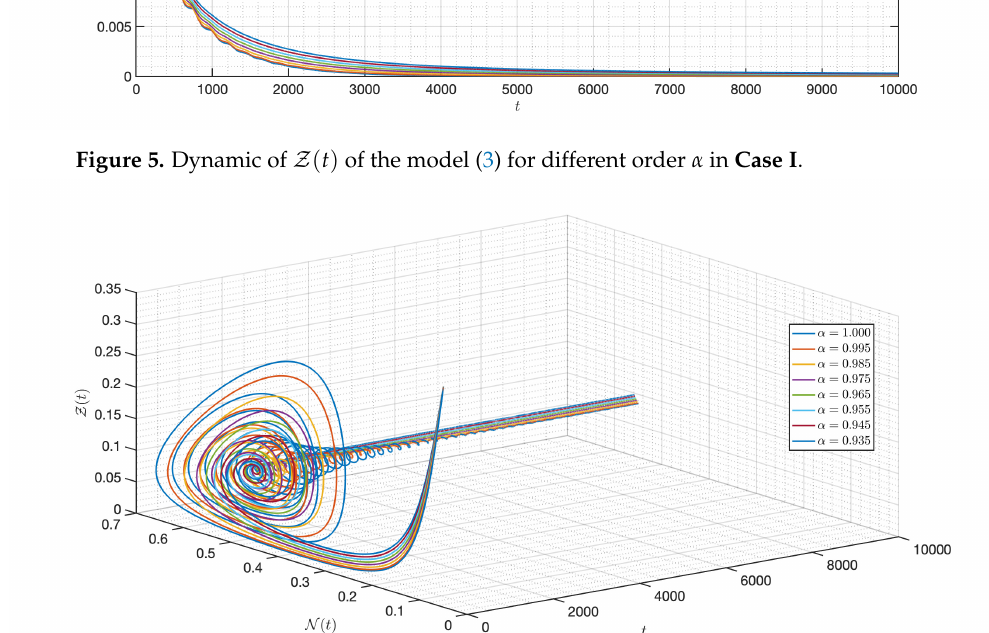
Figure 6. Dynamic of the model (3) for different parameters in Case I